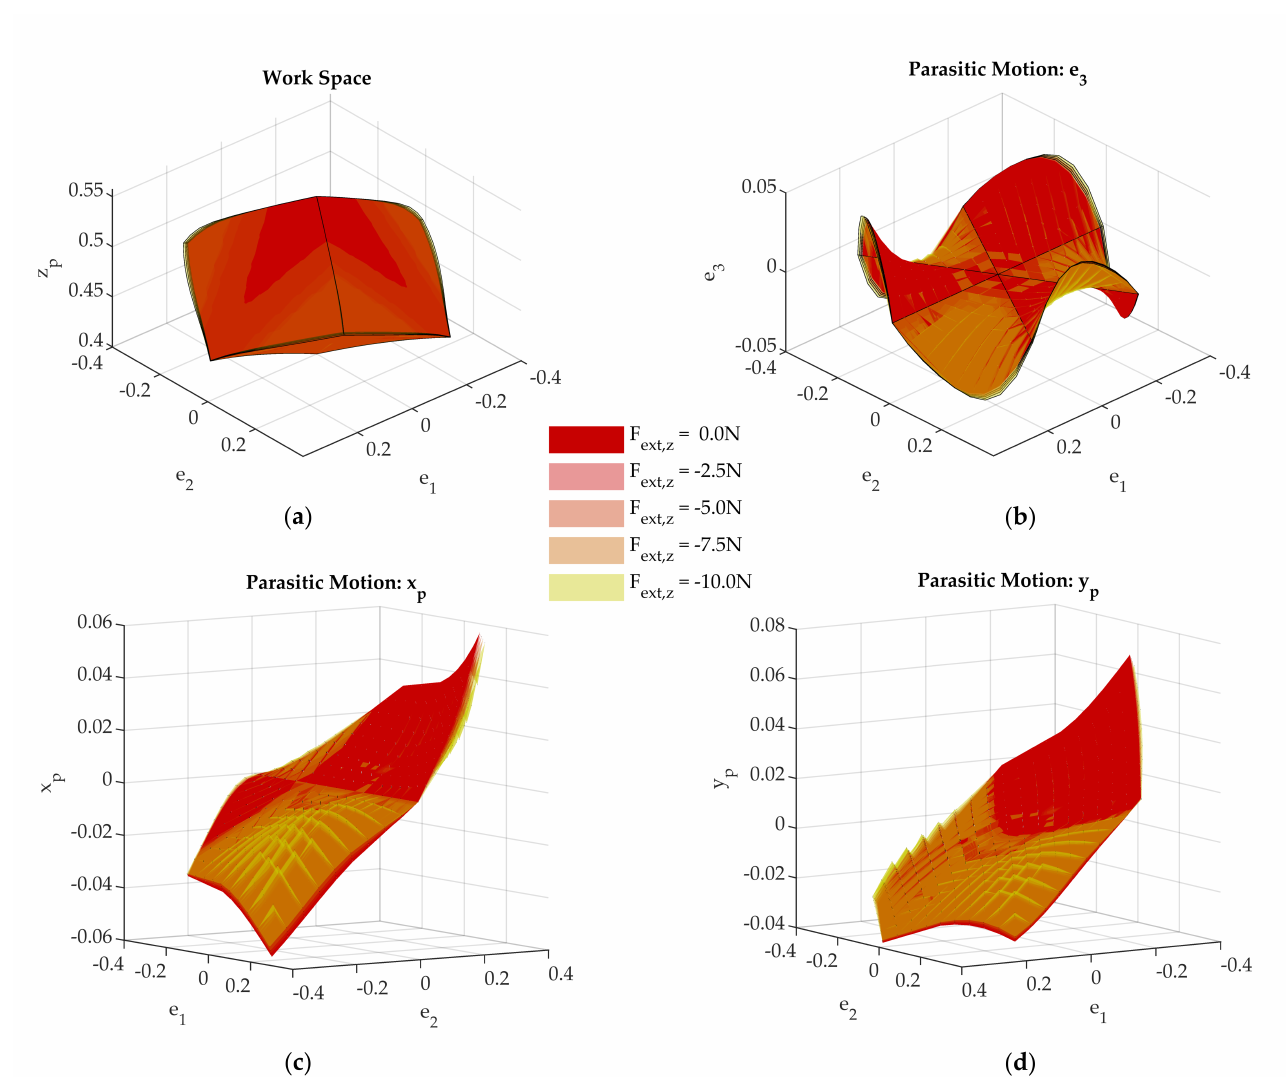
Figure 14. Influence of vertical centred loads on the 3 PFS output parameters e 1 , e 2 , and z p ( a ), and parasitic motions e 3 ( b ), x p ( c ), and y p ( d